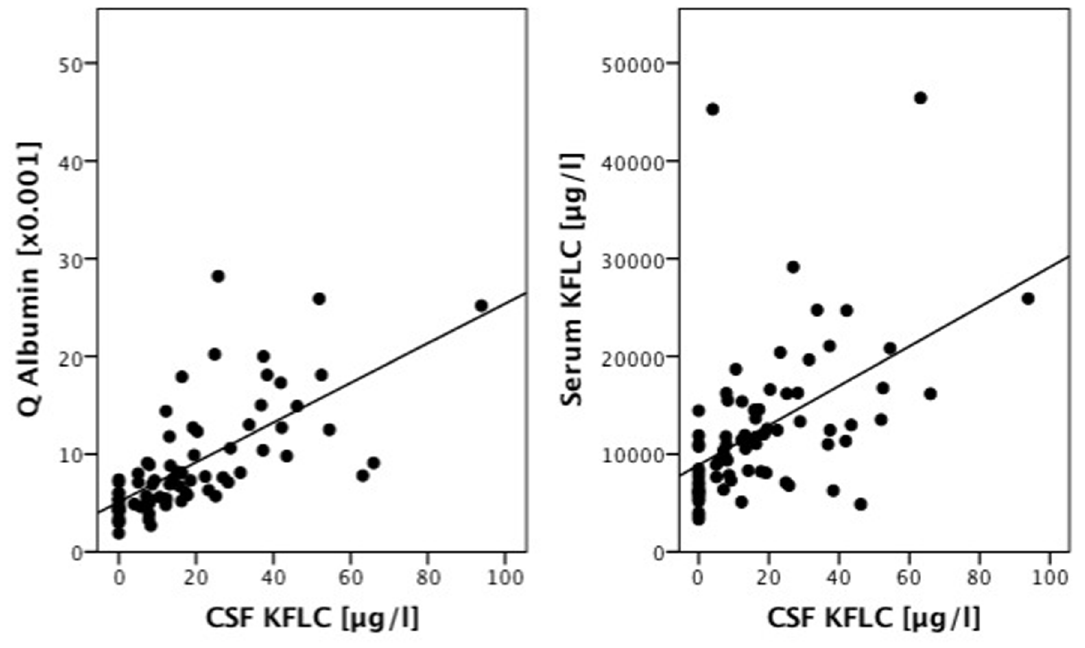
Figure 1. Correlation among cerebrospinal fluid kappa free light chain (CSF KFLC) levels in non-inflammatory neurologic diseases (n=77) and CSF-serum ratio of albumin (Q Albumin)(left; p , 0.001, R=0.775) and serum KFLC levels (right; p , 0.001, R=0.587) are shown. The straight lines are regression lines.